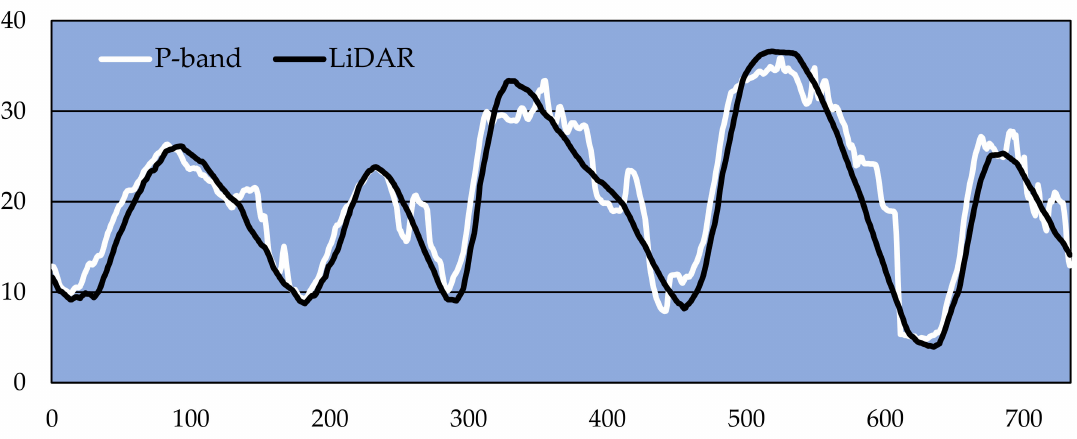
Figure 14. A typical local profile showing that the main errors are located on slopes facing away from the radar (radar illumination from left to right).